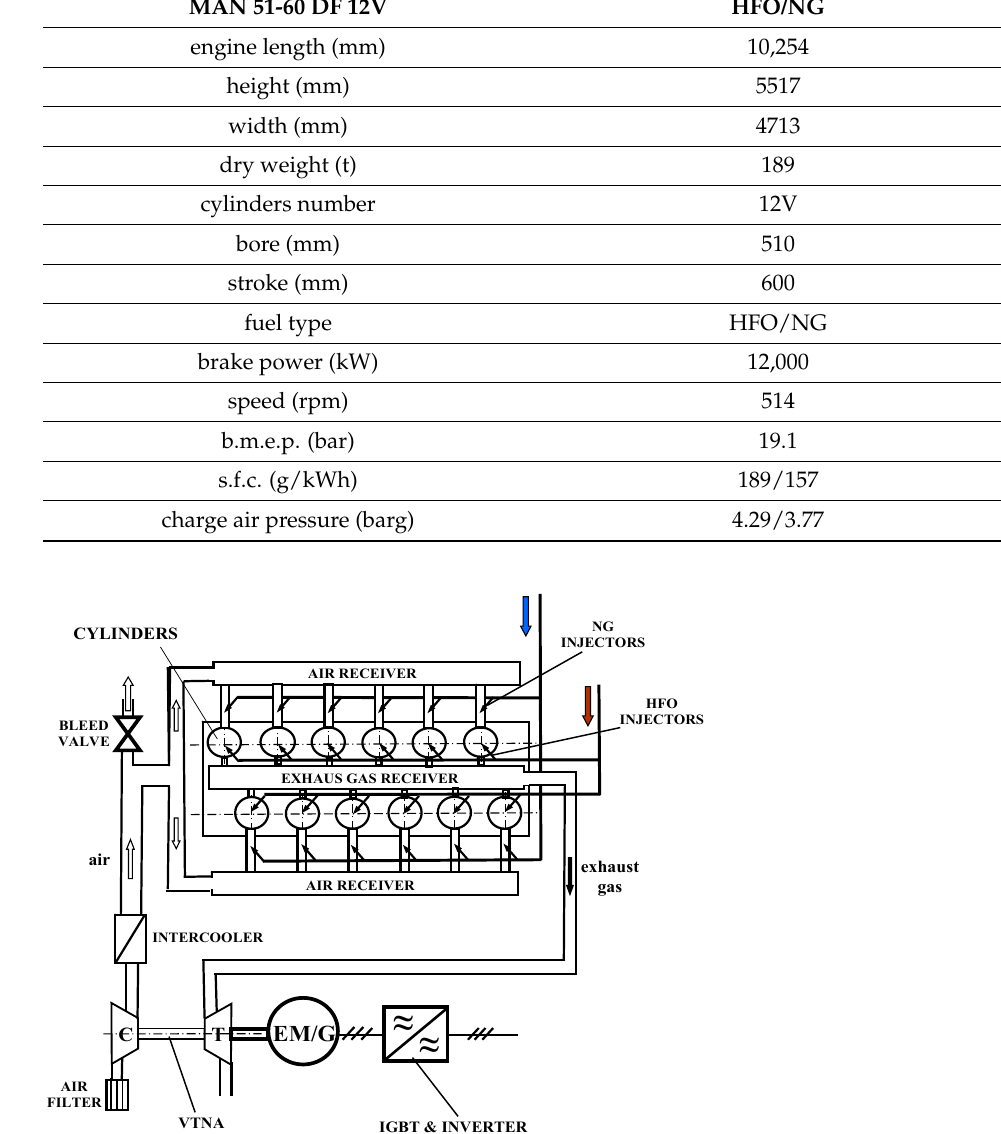
Table 1. Engine dimensions and design data [21].